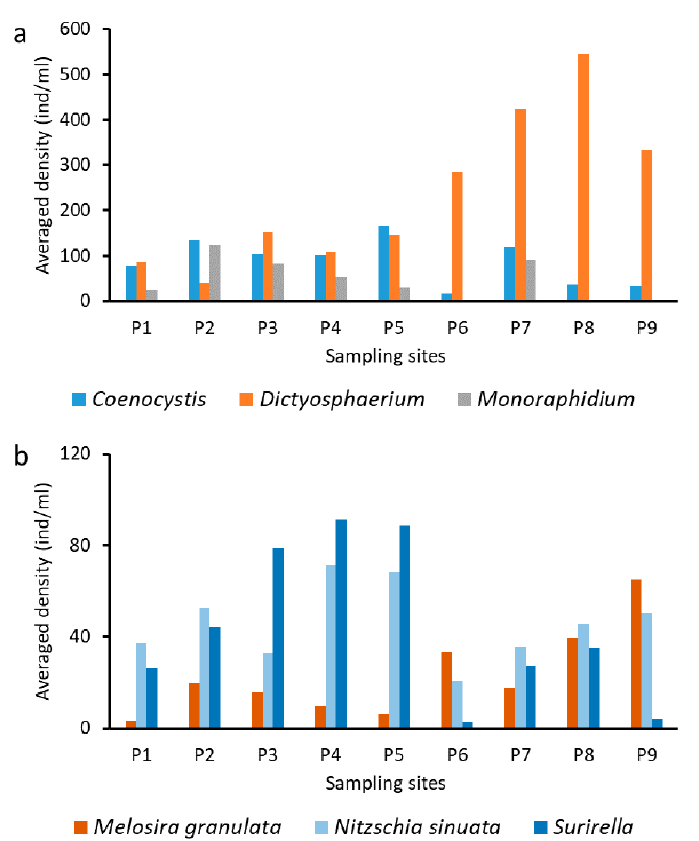
Figure 10. Spatial distribution of temporal averaged density of main algae groups in Estero Salinas Grandes. ( a ) Chlorophytes, ( b ) Diatoms.